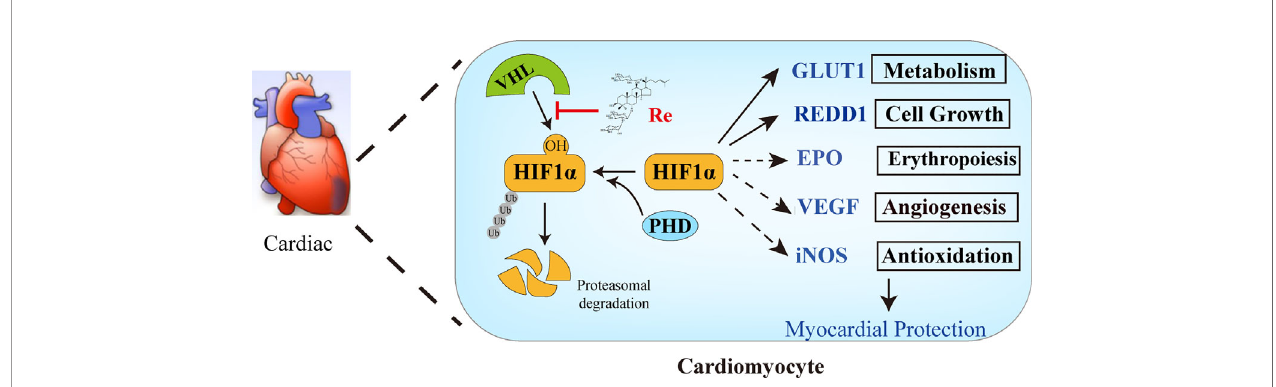
FIGURE 6 | The possible mechanism of ginsenoside Re attenuating myocardial injury induced by H/R. Ginsenoside Re inhibited the ubiquitination of HIF-1 a via inhibiting the binding between VHL and HIF-1 a . In addition, the target genes of HIF-1 a , such as GLUT1 and REDD1, increased following ginsenoside